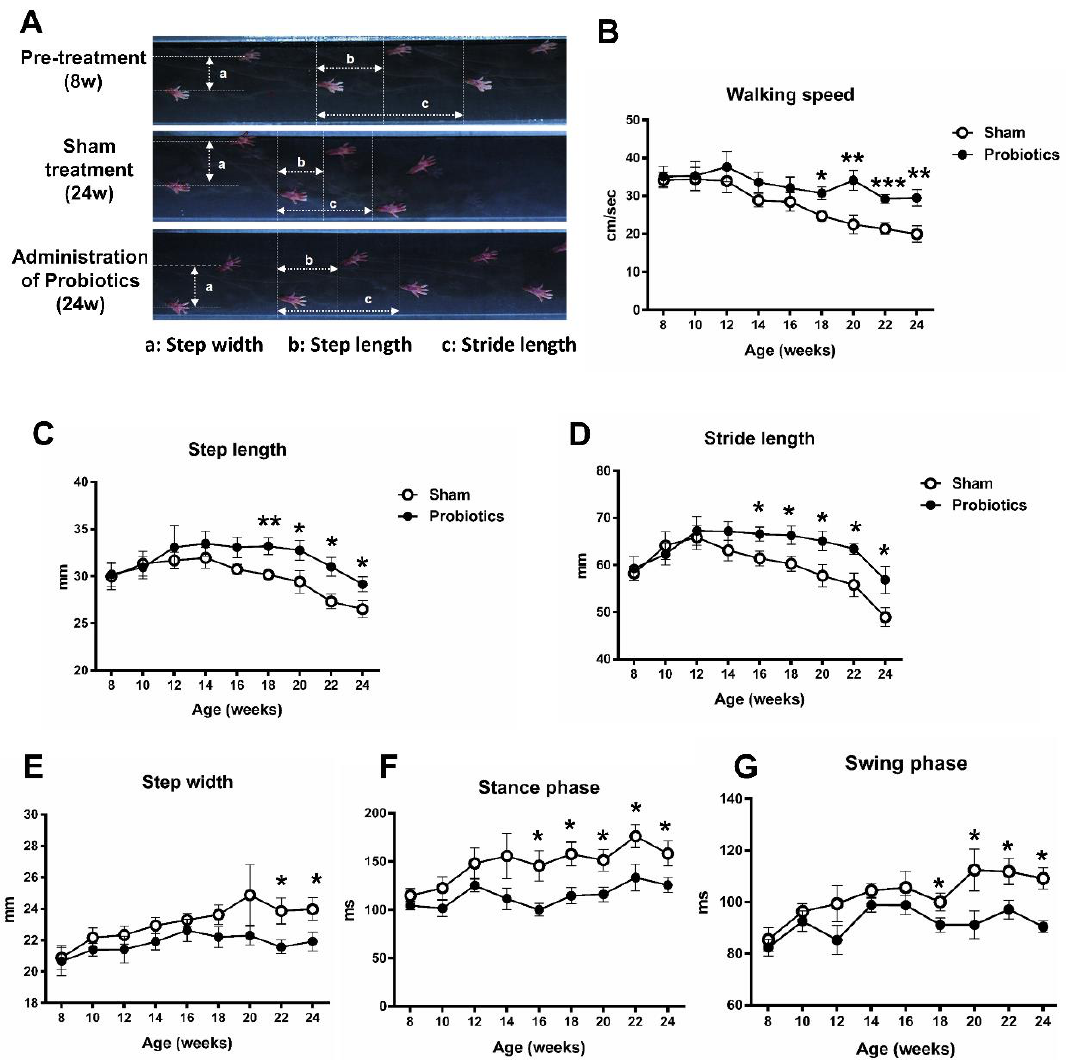
Figure 3. Characteristics of stepping footprints during a 2-sec walkway walking for an 8-week-old MitoPark PD mouse, a 24-week-old MitoPark PD mouse with non-probiotic treatment, and a 24- week-old MitoPark PD mouse with long-term probiotic treatment ( A ). Time-course changes in walking speed ( B ), step length ( C ), stride length ( D ), step width ( E ), stance phase time ( F ), and swing